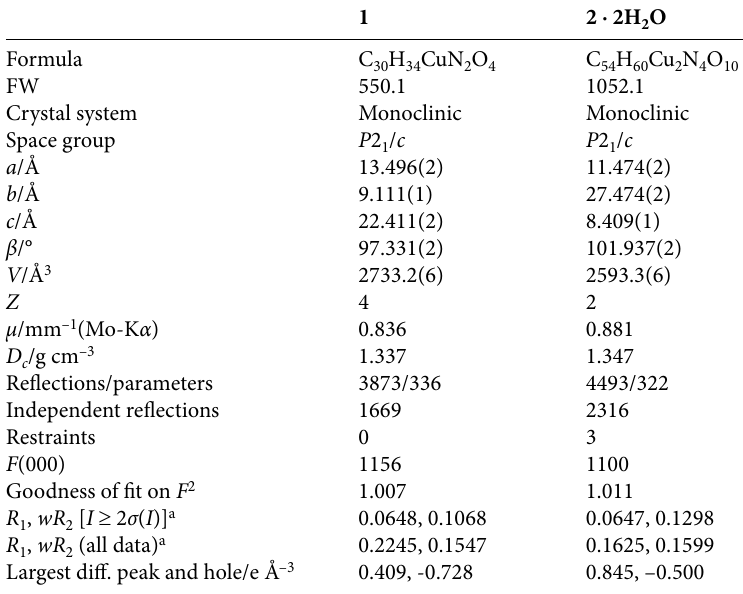
Table 1. Crystallographic and experimental data for complexes 1 and 2 · 2H 2